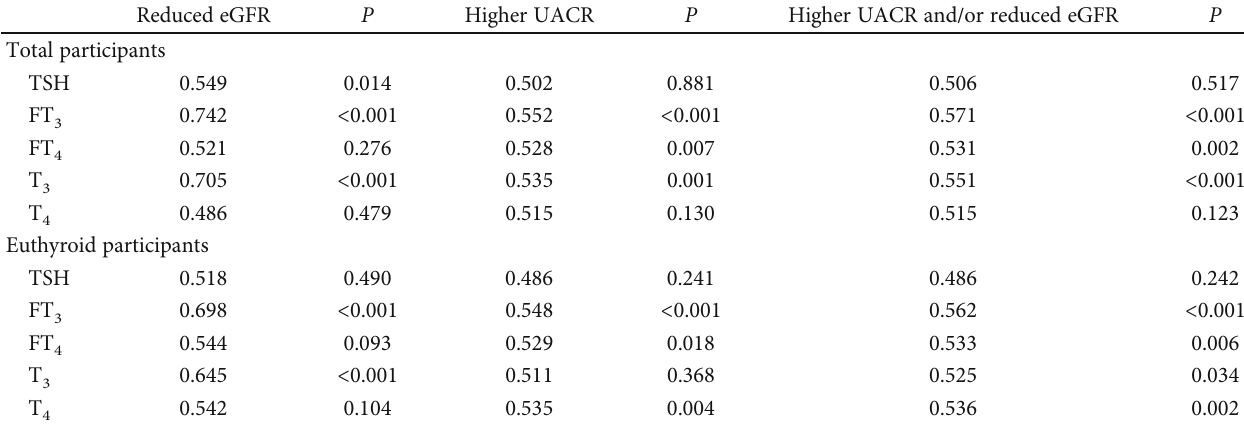
Table 3: Comparison of AUROC between thyroid hormones for kidney disorders.